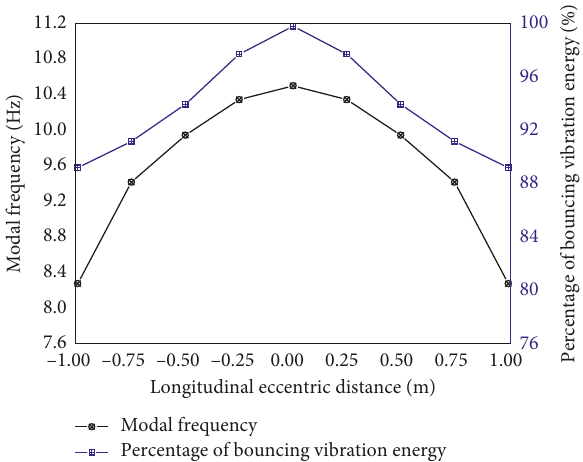
Figure 11: Influence of the longitudinal eccentricity on the modal frequency and energy